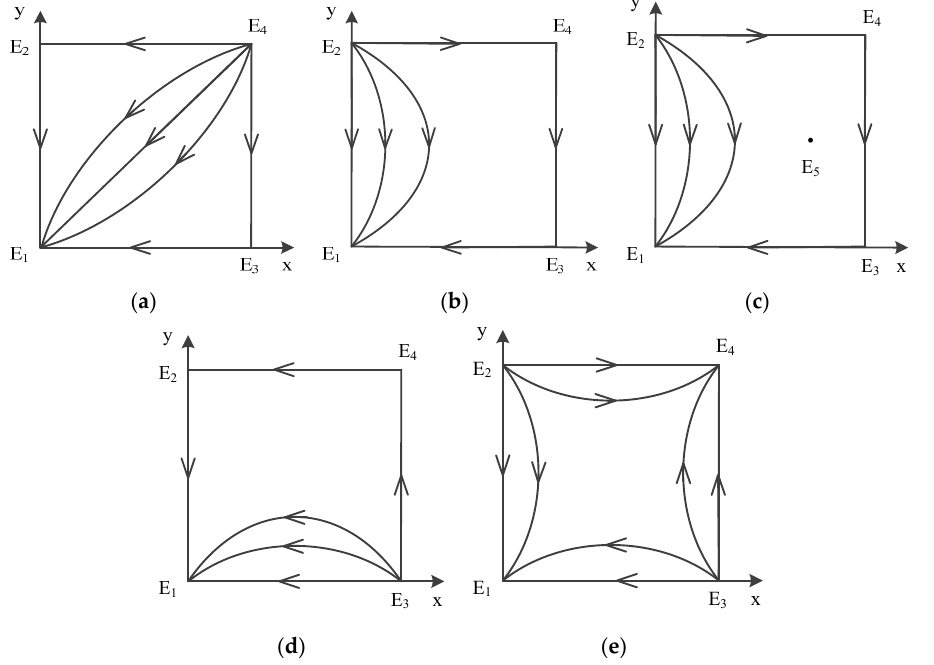
( ) 0,0 E 1 , ( a ) Case 1 ( b) Case 2-1